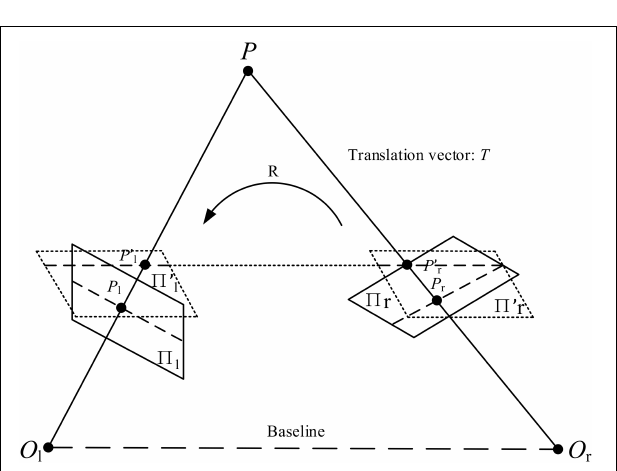
FIGURE 10 | The Image-2 after binarization.